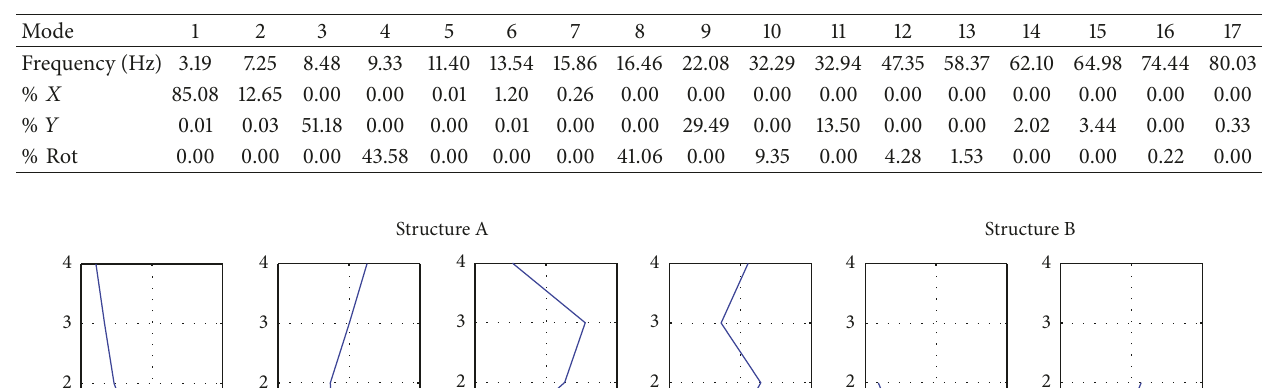
mode in 𝑦 direction; it corresponds to the one identified as mode 3 in Table 11. Instead, the last two identified modes of Table 11 (mode 6 and 7) are not related to any of the modes shown in the numerical FE model. The comparison between the numerical and the experimentally identified seismic eigenvectors, here not reported for the sake of brevity, showed a good correspondence, with errors having the same order of magnitude obtained in the NC case. Thus, the was applicable both in the NC and in the RC